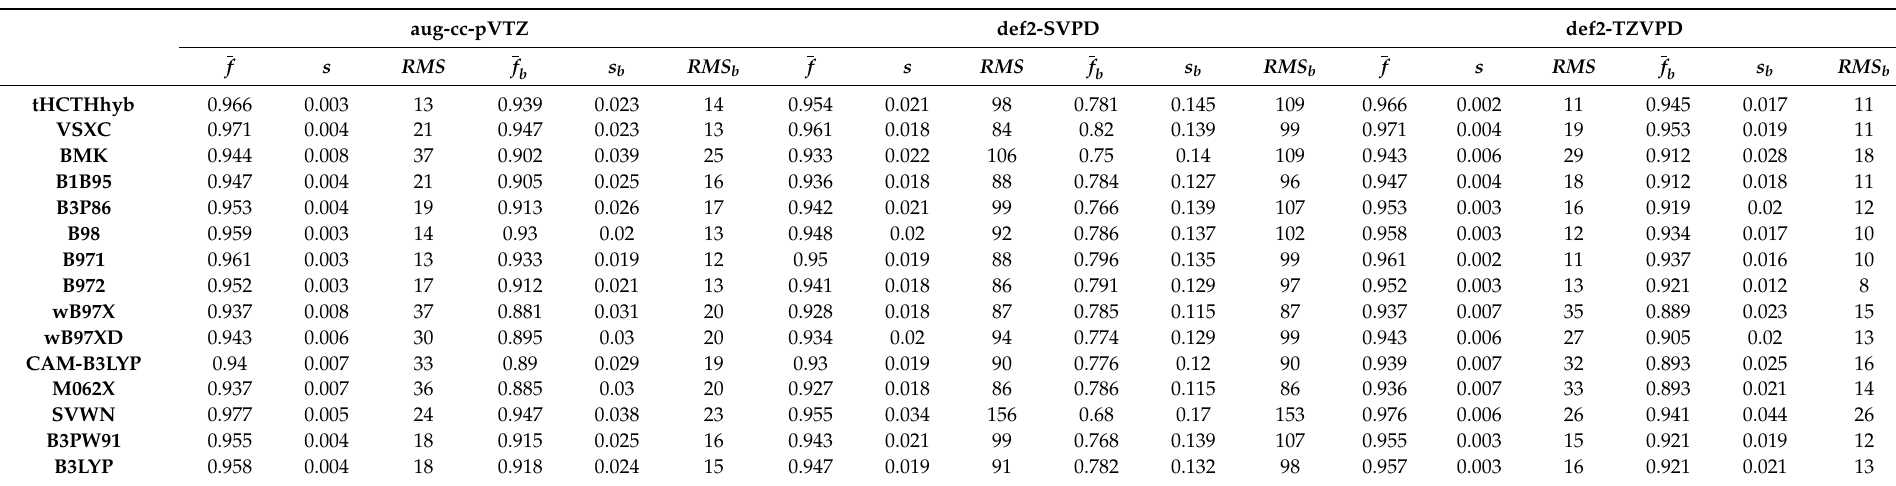
Table 5. Scaling factors for fundamental vibrational frequencies of S 0 states. Reference values taken from gas-phase